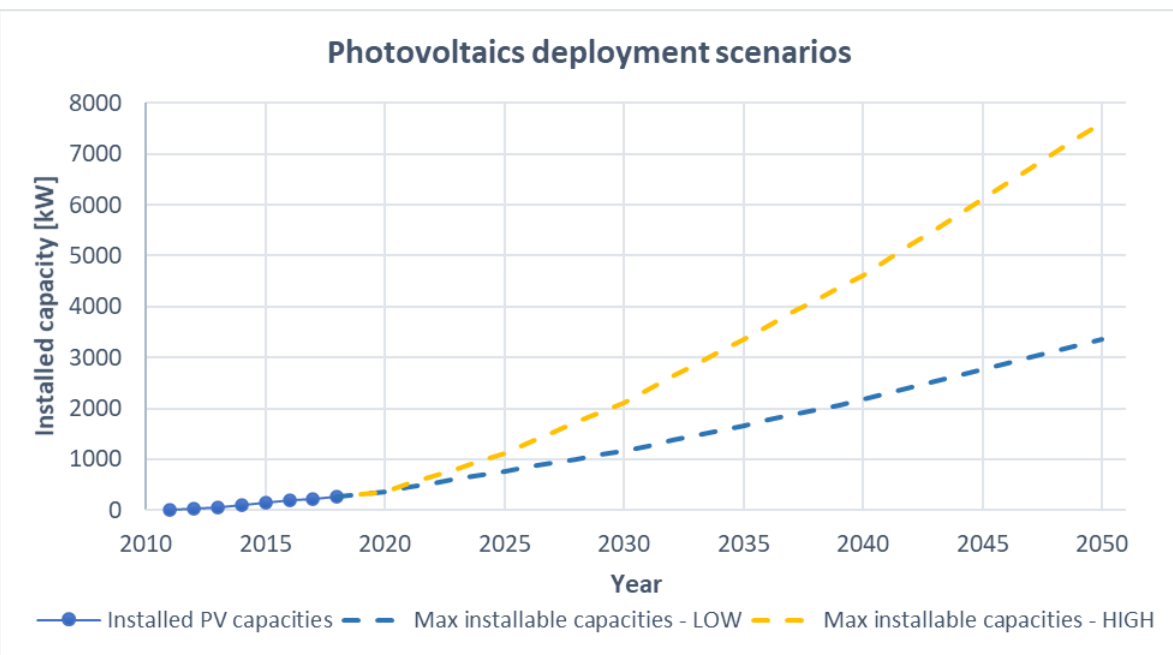
Figure 8. Max installable capacities constraint used to define the LOW and HIGH scenarios.